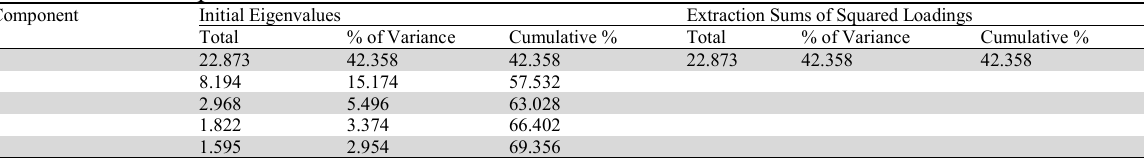
Total Variance Explained Component Initial Eigenvalues Extraction Sums of Squared Loadings